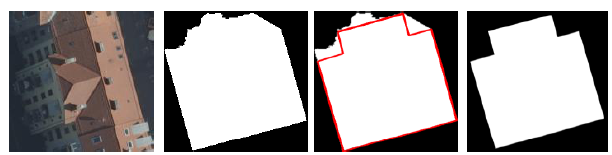
Figure 8: (a) building visible in vertical aerial image (b) segmentation result (c) in red modified building outline using 3D facade reconstruction (d) enhanced building footprint.